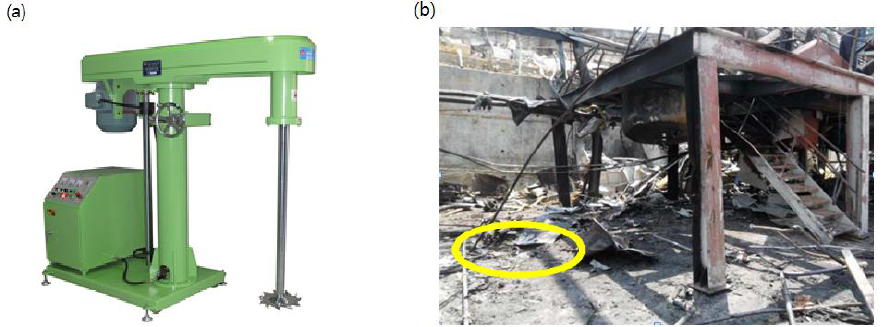
Figure 5. ( a ) Same apparatus as the dissolver used in the event of an accident and ( b ) debris of the burnt factory after the accident. The circled portion in the picture was the position of the dissolver. A small crater from the explosion can still be seen.